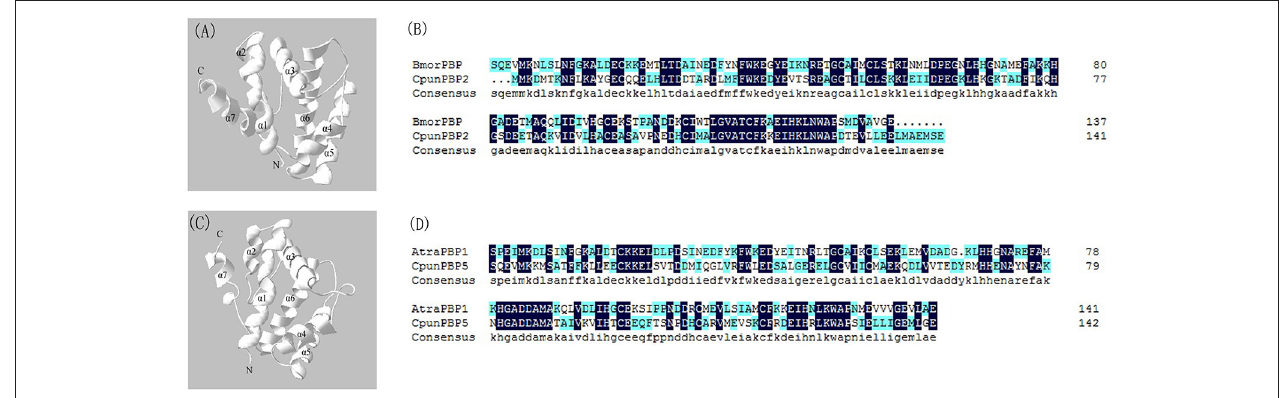
FIGURE 4 | 3D structure model of the CpunPBP2 and CpunPBP5. (A) Predicted 3D model of CpunPBP2 was built on structure of PBP1 from Bombyx mori . Seven α -helixes, N-terminal (Nt) and C-terminal (Ct) are marked. (B) Sequence alignment of CpunPBP2 and BmorPBP. In the alignment of the two proteins, identical residues are highlighted in blue. (C) Predicted 3D model of CpunPBP5 was built on structure of PBP1 from Amyelois transitella . Seven α -helixes, N-terminal (Nt) and C-terminal (Ct) are marked. (D) Sequence alignment of CpunPBP5 and AtraPBP1. In the alignment of the two proteins, identical residues are highlighted in